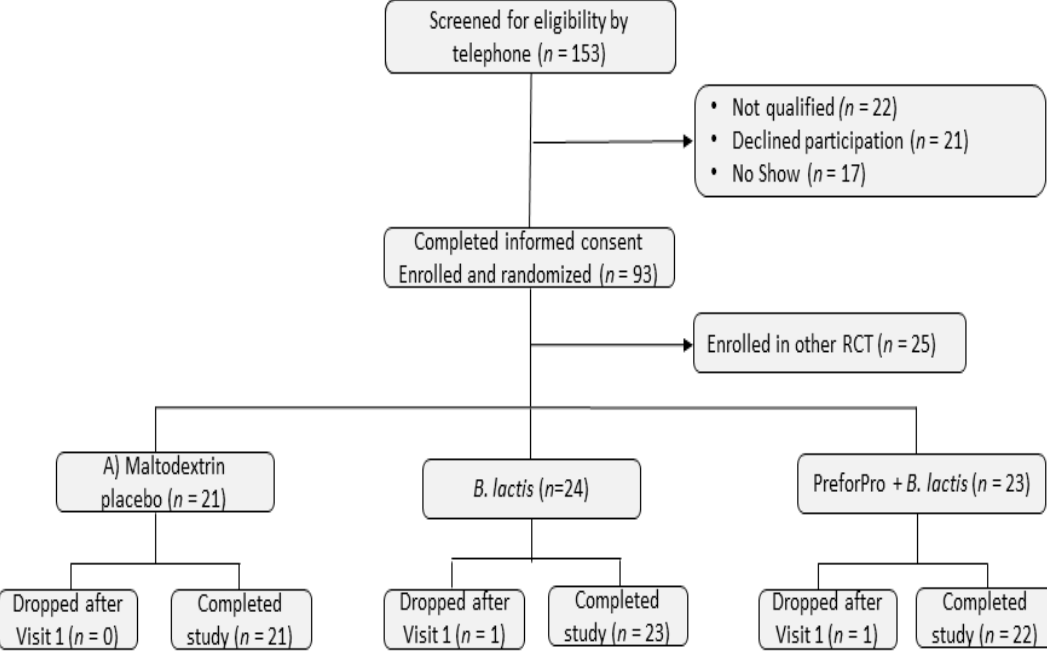
Figure 1. Consort flow diagram of participants through study enrollment to completion.